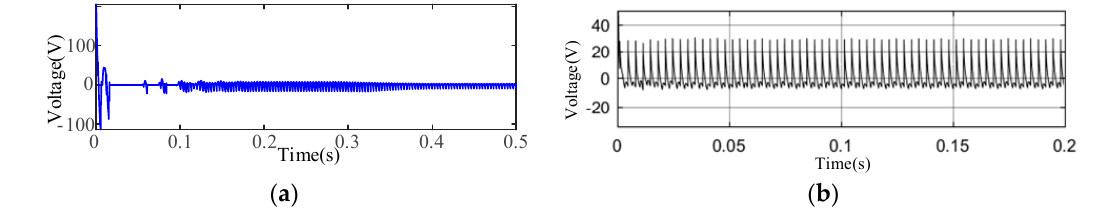
Figure 21. Voltage drop on the smoothing reactor: ( a ) DNMFRF and ( b ) LCF.